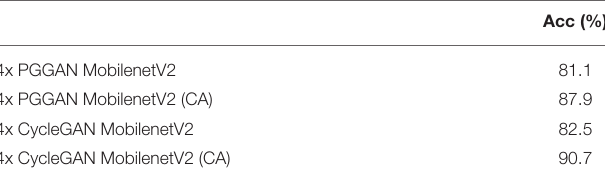
TABLE 3 | GAN augmentation classification results without kmeans.